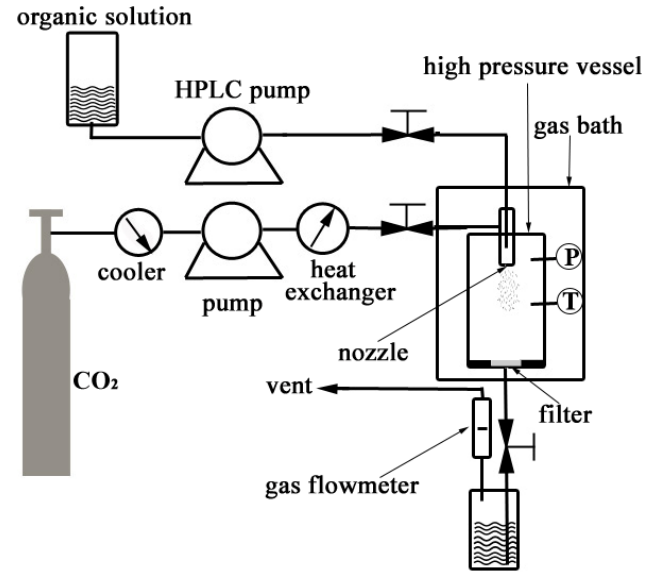
Figure 4. Schematic diagram of the apparatus for the SEDS